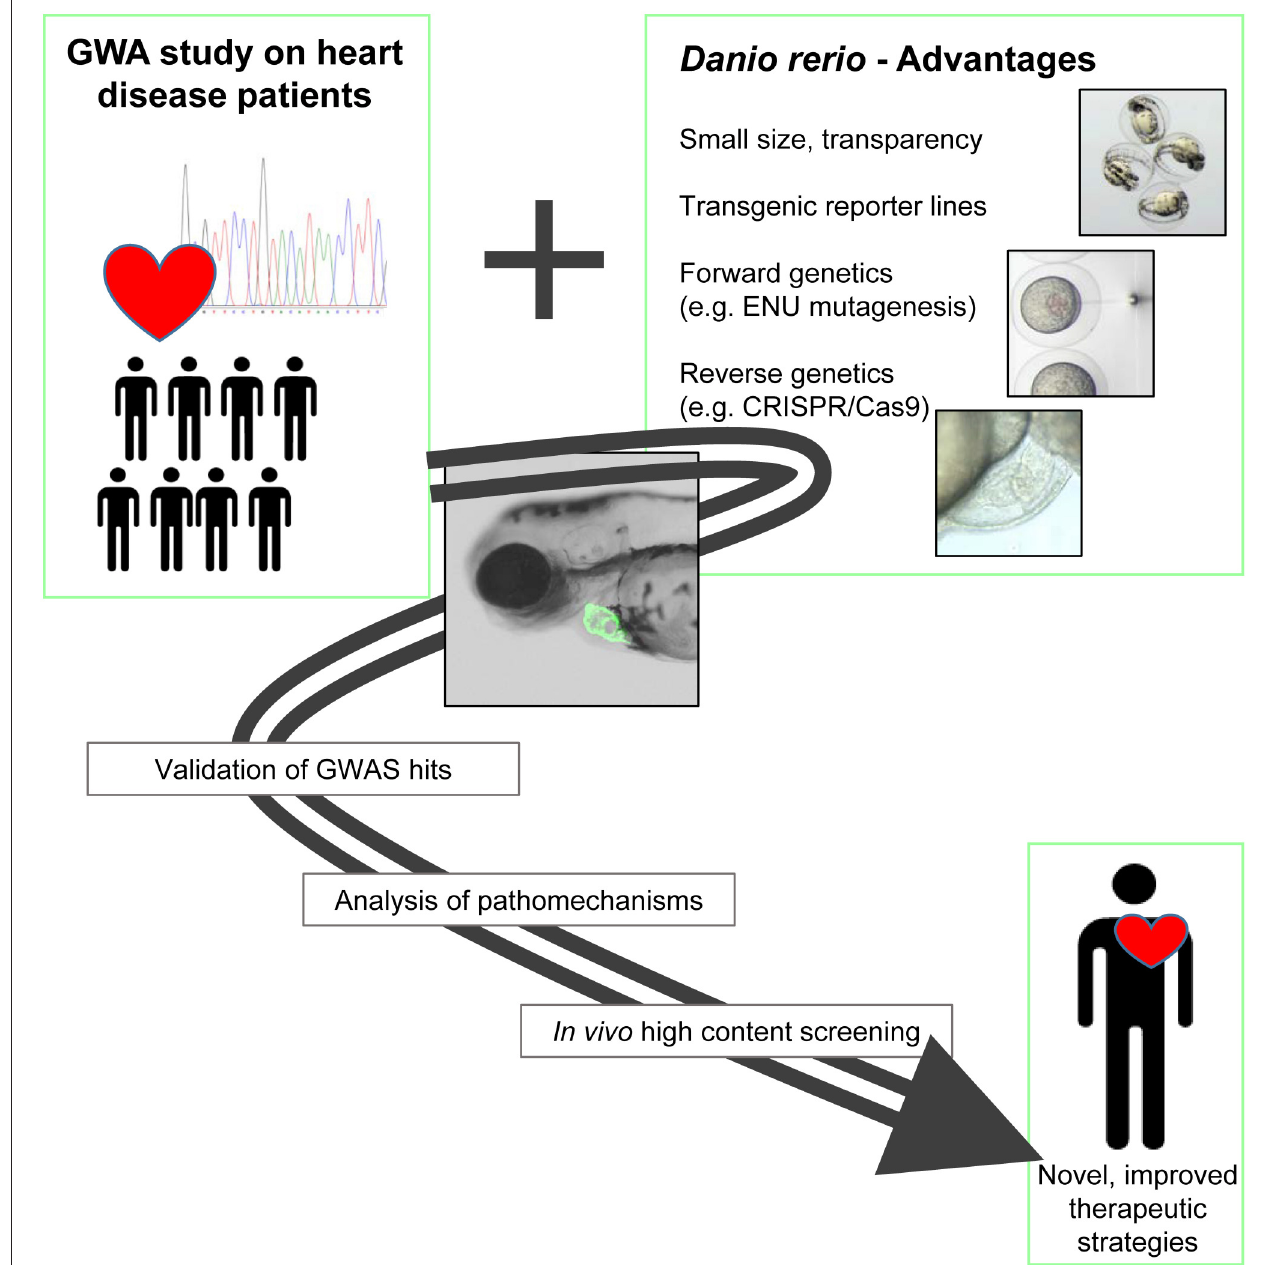
FIGURE 1 | GWAS and zebrafish: a powerful combination for cardiovascular research. The benefits of the zebrafish as an experimental system can enormously help to validate the functional relevance of candidate genes identified by GWA studies. In addition, the system enables the in vivo analysis of underlying pathomechanisms and is highly suitable for high throughput screening applications. In summary, the combination of GWAS and the zebrafish experimental system has the potential to lead to improved and specific therapeutic approaches.